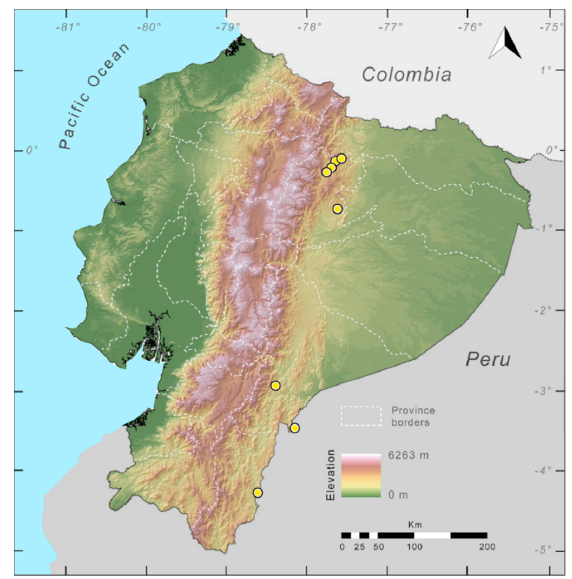
Figure 87. Distribution of Espadarana audax in Ecuador (yellow dots).